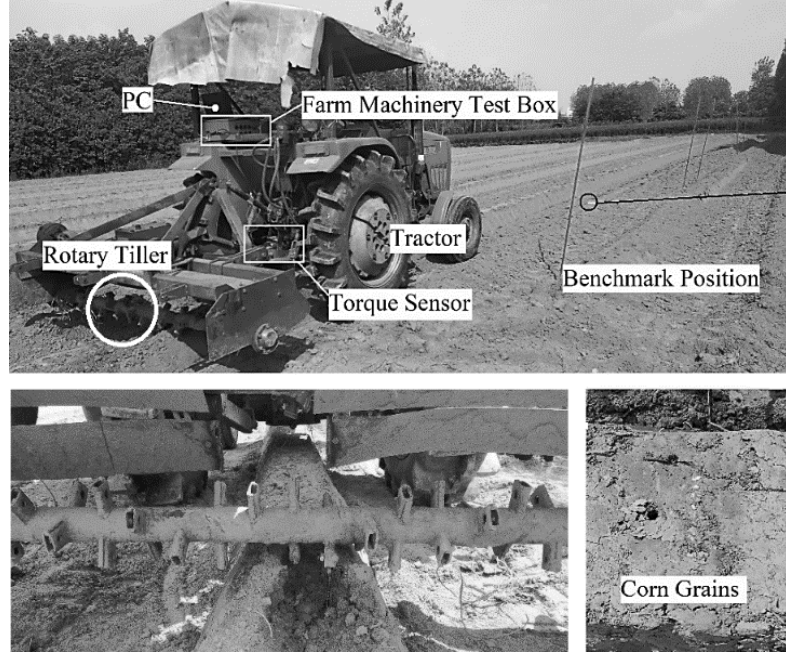
Figure 9. Schematic diagram of field test component links.